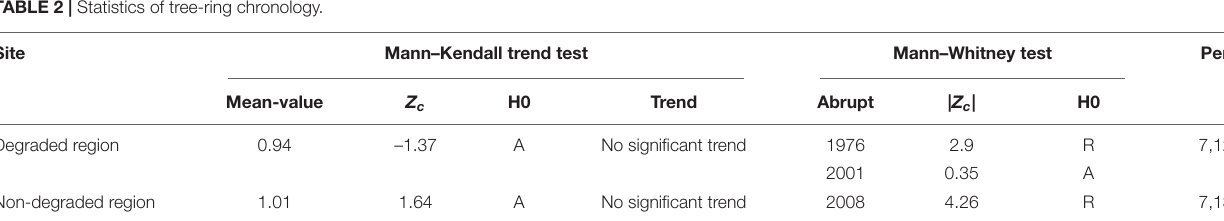
FIGURE 5 | Tendency of tree-ring chronology indices in degraded regions and non-degraded region. TABLE 2 | Statistics of tree-ring